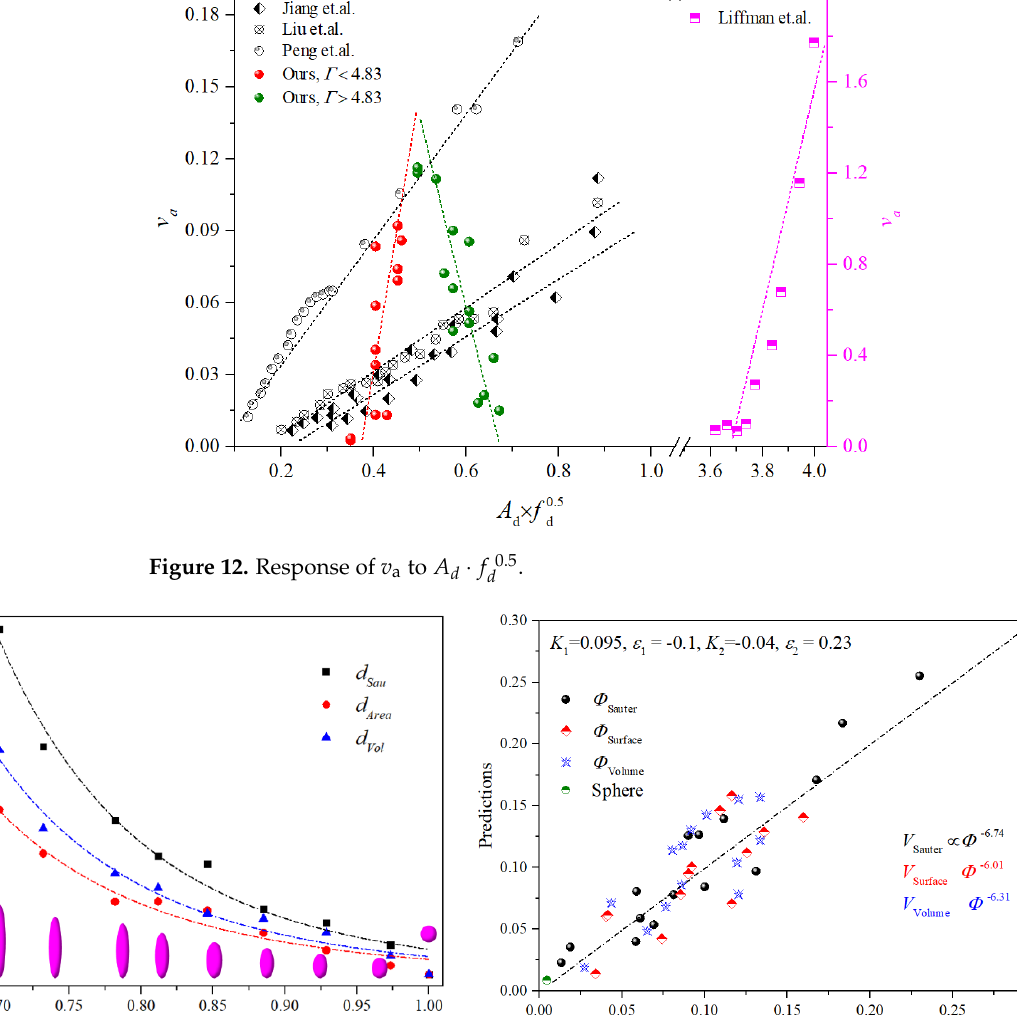
Figure 13. ( a ) The response of v a to the sphericity Φ ; ( b ) the predictive values based on Equation (9) against the simulation data.